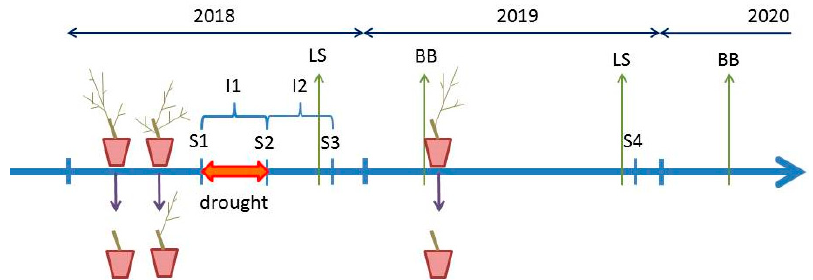
Figure 2. Time line indicating the drought period, pruning events and measurements on the plants during the years 2018 till 2020. S1 to S4: size measurements including length and diameter of the shoots. I1 and I2: increments of shoot length and diameter. BB: bud burst, LS: leaf senescence.